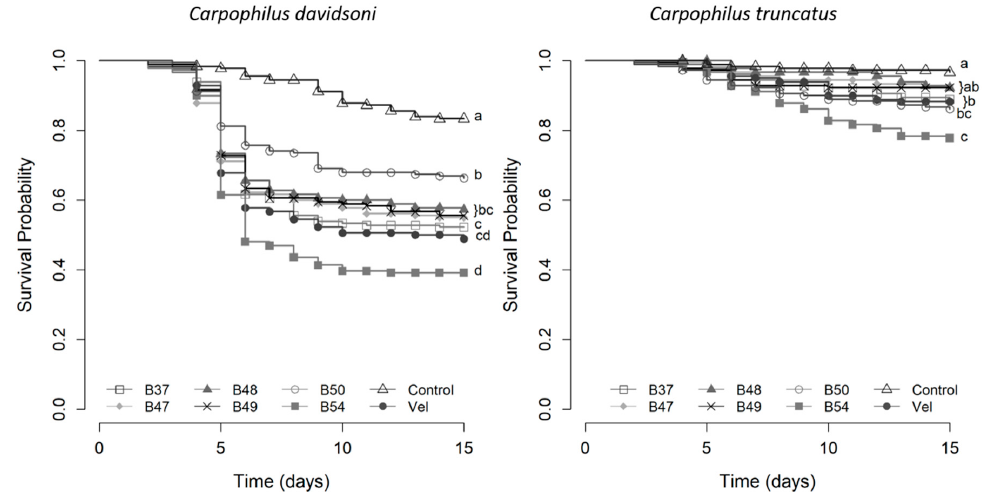
Figure 2. Kaplan–Meier survival curves of adult C. davidsoni ( left ) and C. truncatus ( right ) indicating time–mortality response. Survival curves followed by different letters denote significant difference ( p < 0.05) with a multiple comparisons log-rank test.